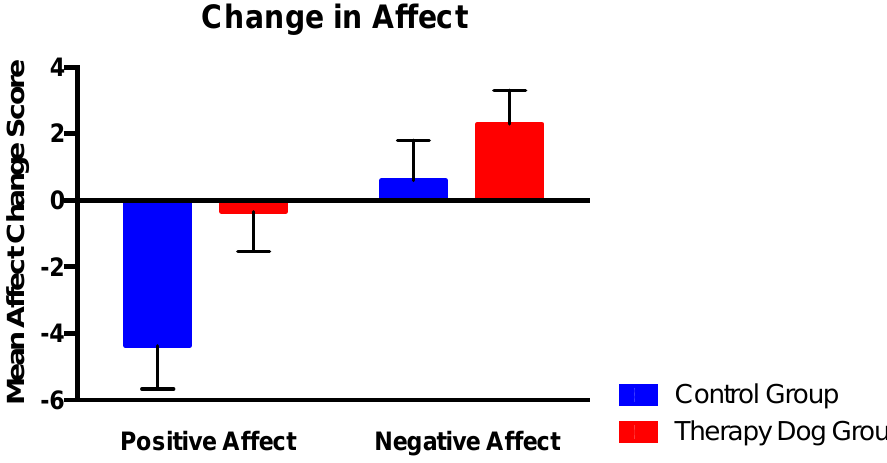
Figure 2. Buffer effect of therapy dog exposure on positive and negative affect.